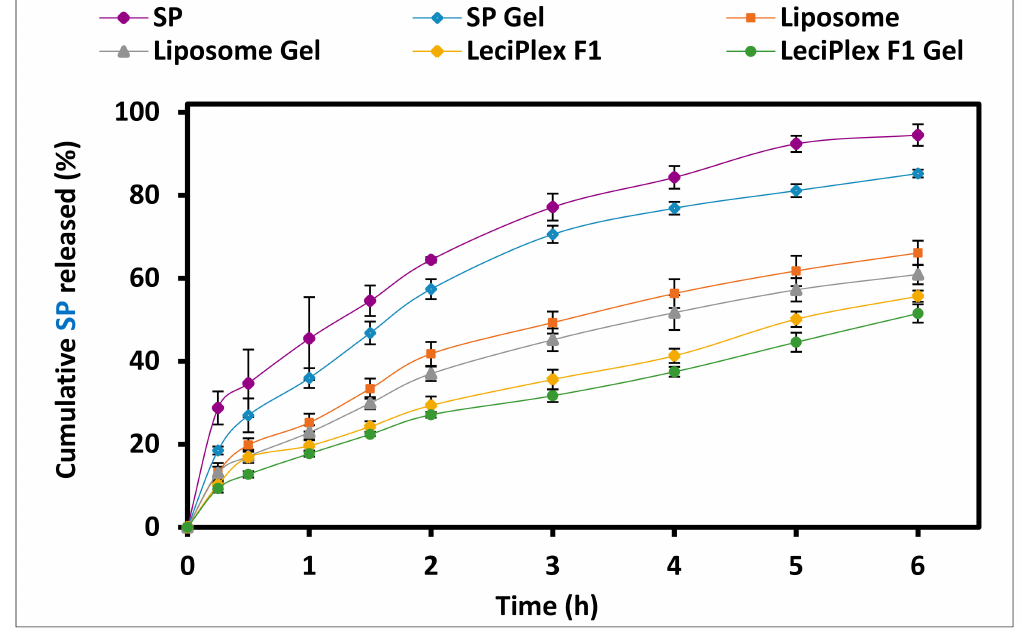
Figure 4. In vitro SP release from di ff erent formulations in phosphate-bu ff ered saline pH